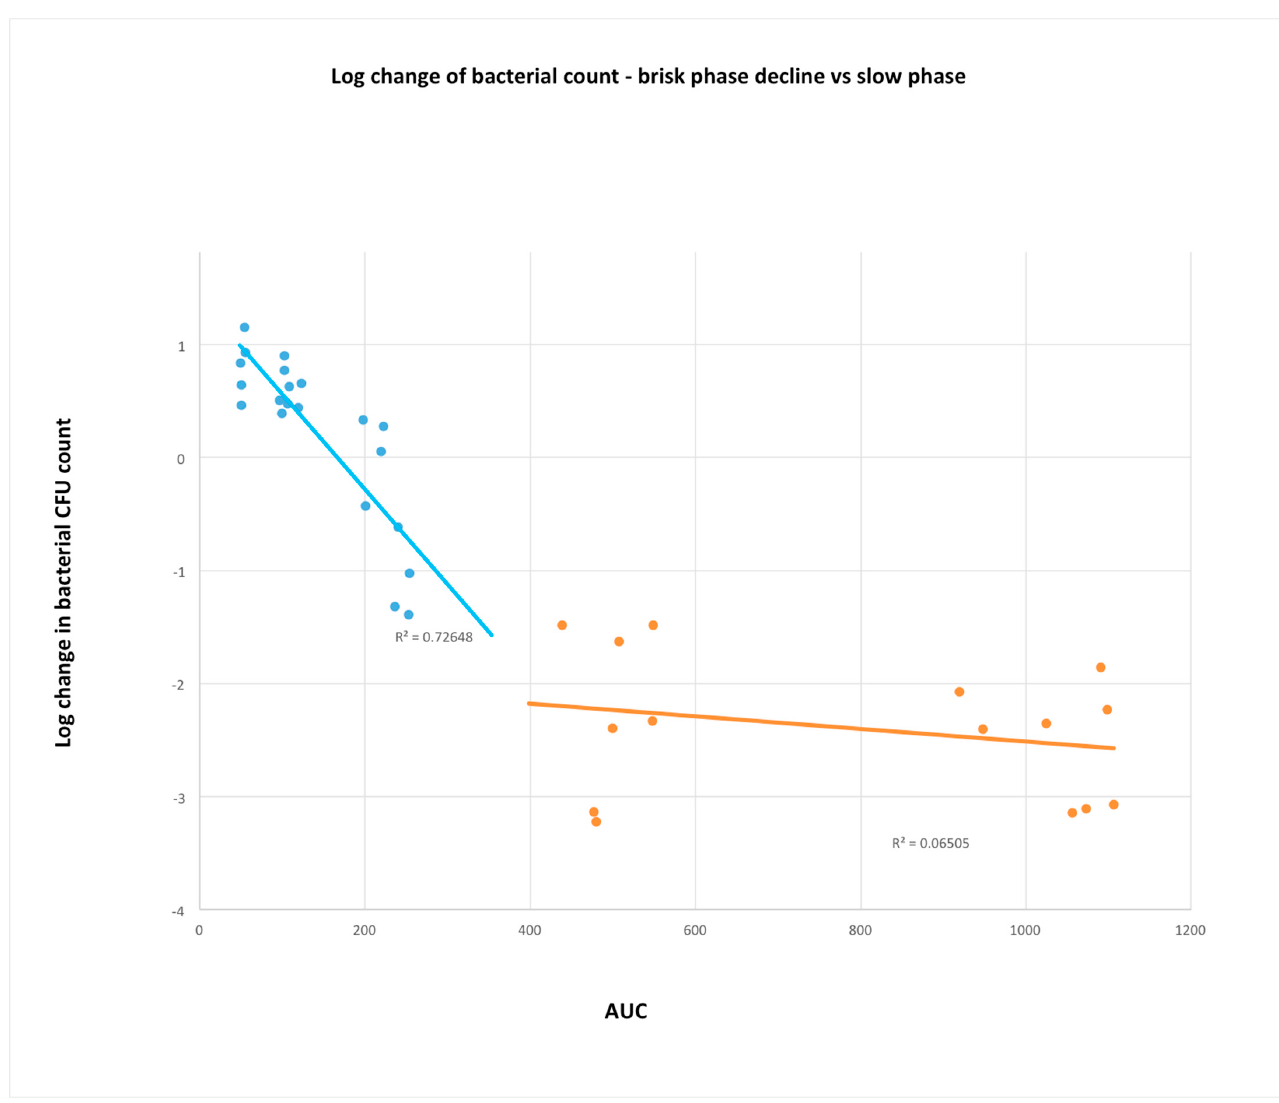
Figure 4. MSSA data from Ebert et al. ([29]) extracted from graphs of Rybak 2006 ([23]). Area under the curve versus log change in bacteria over 24 h in neutropenic mouse − thigh infection model. Replotted with linear x − axis and divided dataset by responsiveness. Blue datapoints and regression line represent a brisk response at AUC ~50–400. Orange datapoints and regression line demonstrate AUC values where very little concentration-dependent activity is observable.